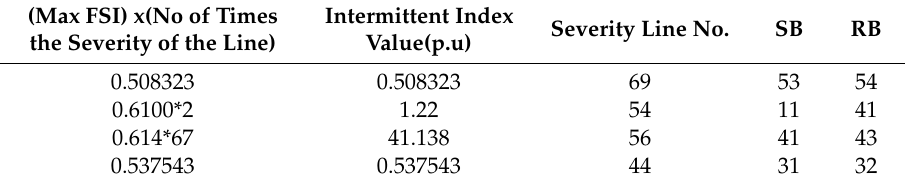
Figure 5. Probability of occurrence severity lines in IEEE-57-bus system. Table 7. Contingency analysis by intermittent approach.